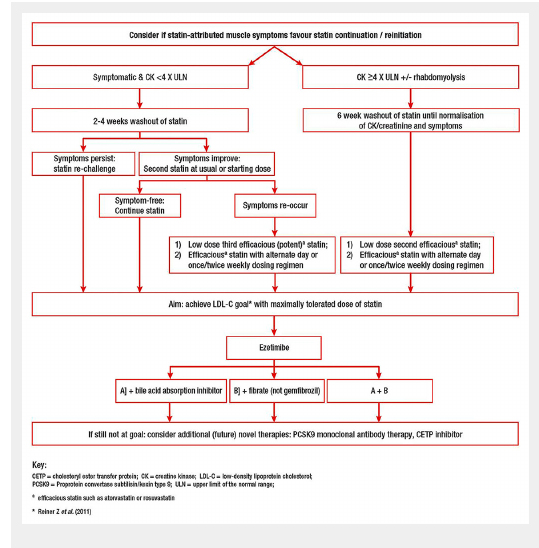
Proposed algorithm for management of patients with statin- associated muscle symptoms. Adapted with permission from [5]. CETP = cholesteryl ester transfer protein; CK = creatine kinase; LDL-C = low-density lipoprotein cholesterol; PCSK9 = proprotein convertase subtilisin/kexin type 9; ULN = upper limit of the normal